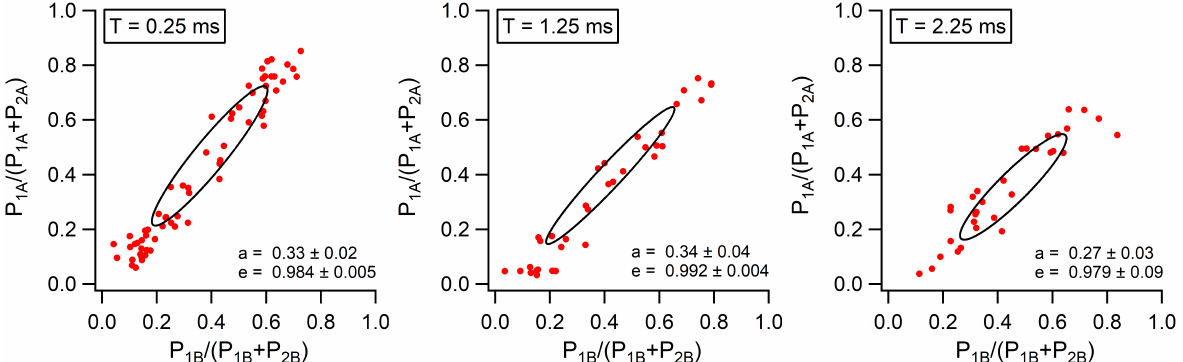
Figure 5. Ellipse signals at various values of T for a double Mach–Zehnder interferometer. Black curves are best fit ellipses for each data set. These are characterized by e , the eccentricity of the ellipse, and, a , the length of the semi-major